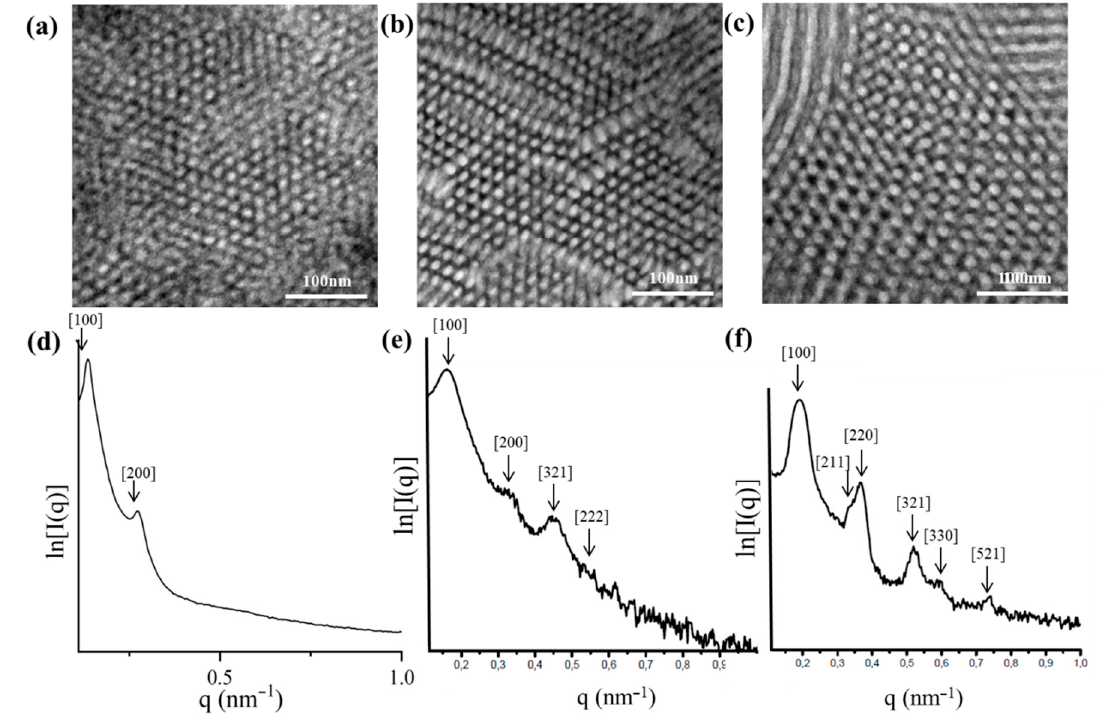
Figure 7. Bright-field TEM images of the dendritic final terpolymer [(PB)(PI)(PS c )][(PS)(PB)(PI c )] 3 (SI 3 core) and the corresponding dendrons (consisting one-quarter and three-quarters of the final dendritic terpolymer), where 3-phase contrast is clearly indicated ( a , b , c ) after staining with vapors of OsO 4 aqueous solution and their relevant 1D SAXS plots ( d , e , f ). PS (white) microdomains are ordered on a tertiary symmetry axis, surrounded by four PB (black) microdomains in a (grey) PI matrix. This morphology resembles the cross-section of cylindrical morphologies and the order is best on the dendrons and worst in the dendritic terpolymer, which can be verified by the number of peaks for the corresponding SAXS